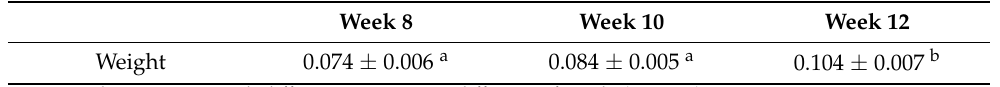
Table 3. Yellow mealworm overall average weight (g).